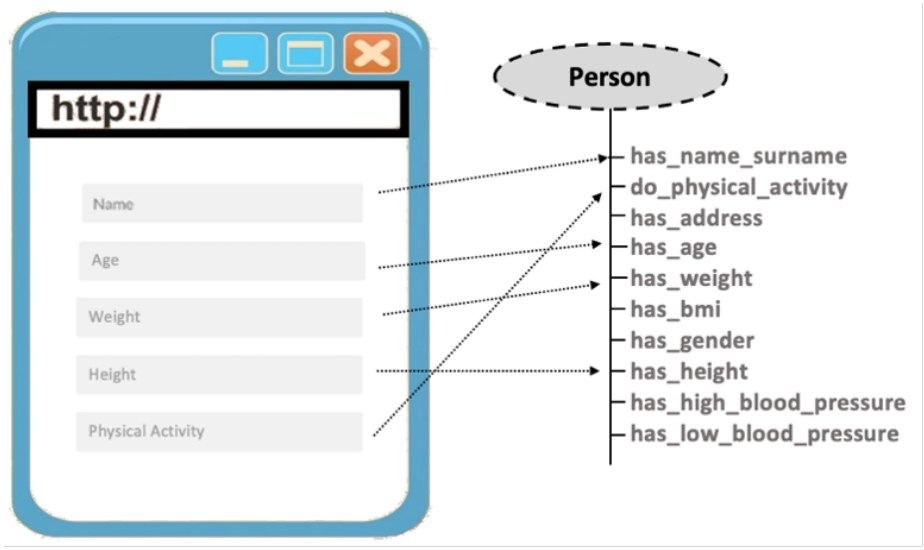
Figure 7. Matching between the user form and the class Person .